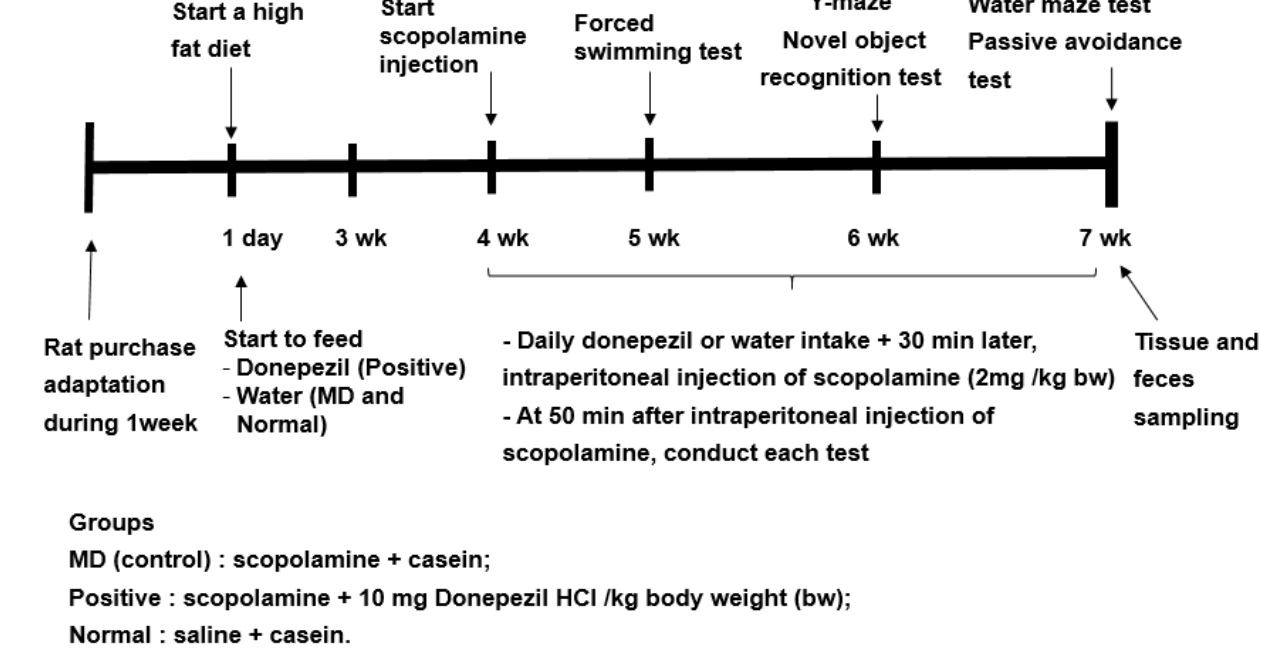
Figure 8. Experimental design for the animal study.